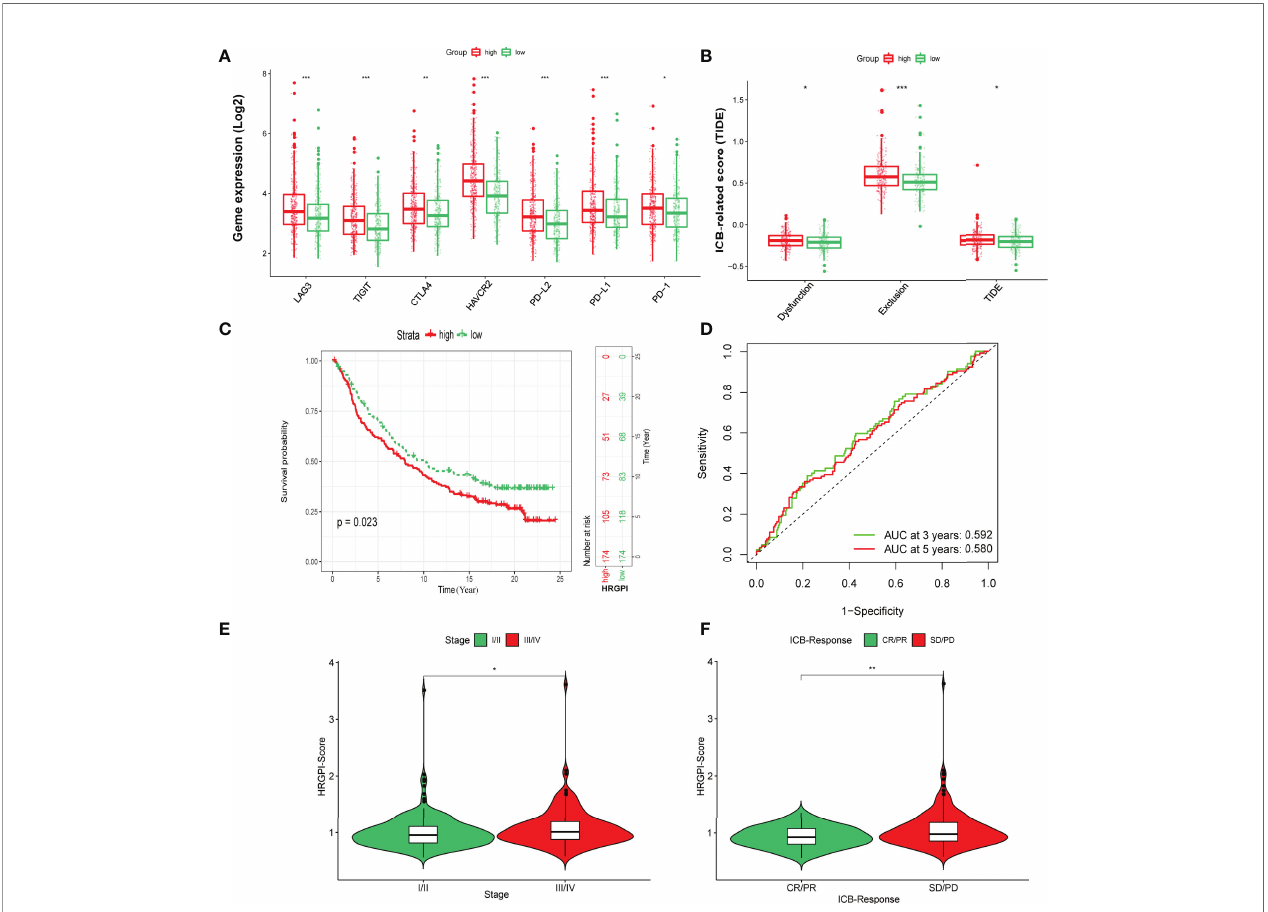
FIGURE 8 | The prognostic value of HRGPI in patients with ICI therapy. (A) Different expressions of immune checkpoints in different HRGPI groups. (B) Different TIDE scores in different HRGPI groups. (C) Kaplan – Meier plots of the HRGPI subgroups in the mUC cohort. (D) ROC curves of HRGPI for the 1-, 3-, and 5-year OS of patients in the mUC cohort. (E) Patients with advanced stages in the mUC cohort have a higher HRGPI score. (F) Patients with SD/PD status after ICI treatment in the mUC cohort have a higher HRGPI score. ( p < 0.05 *; p < 0.01 **; p < 0.001